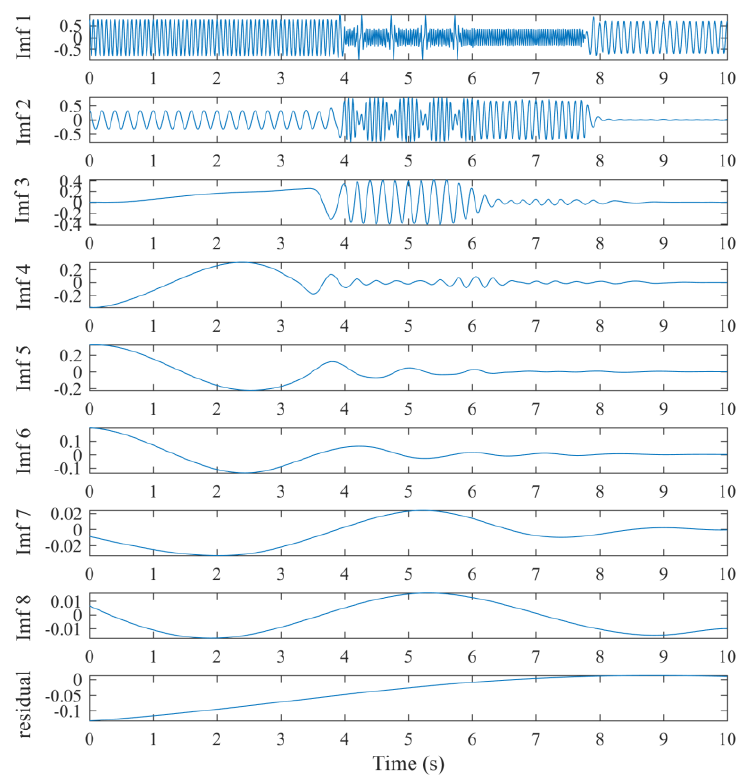
Figure 4. The EMD decomposition results and the residual.